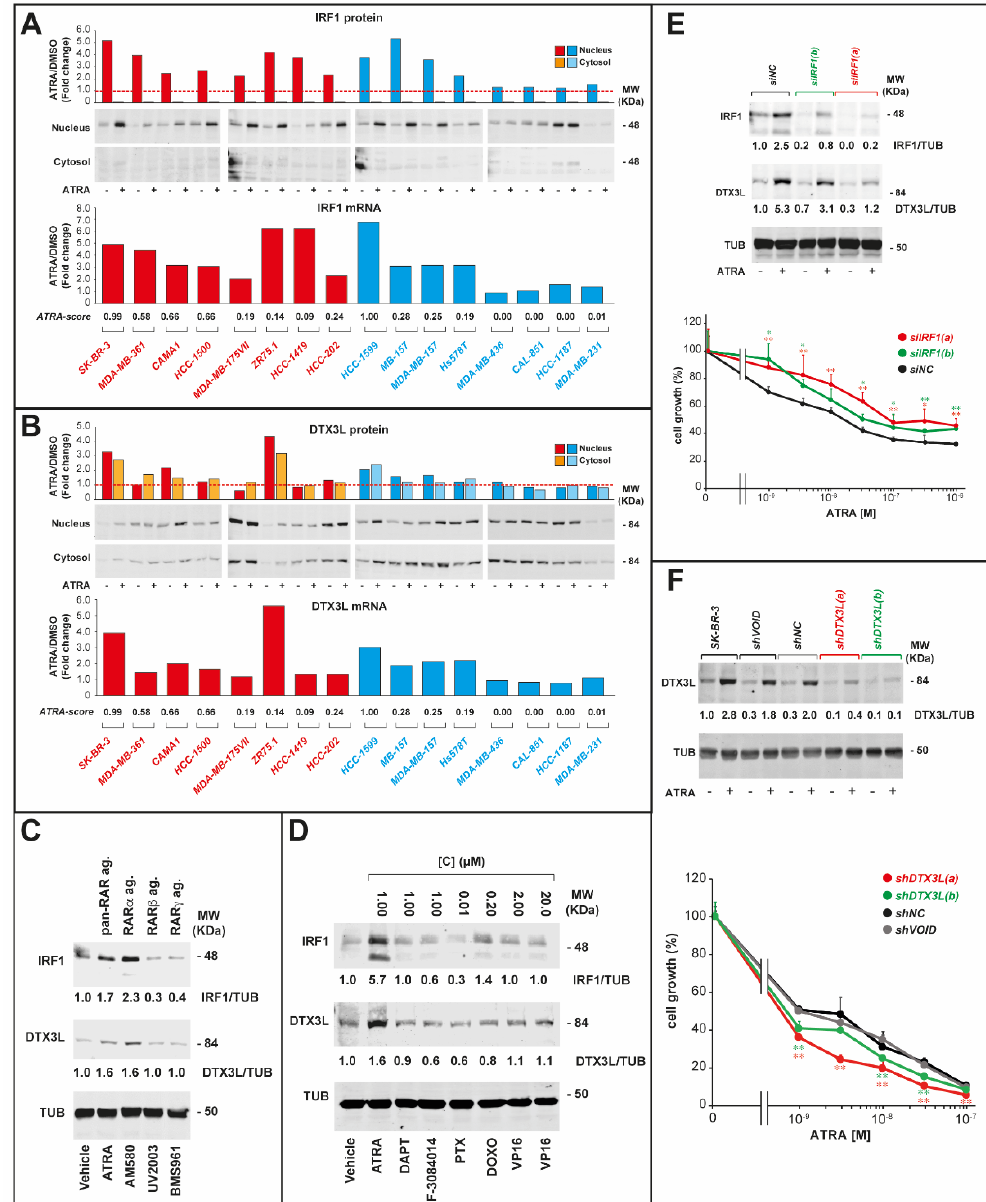
Figure 7. Effects of ATRA and derived retinoids on IRF1 and DTX3L in breast cancer cell-lines and functional significance of the two proteins in ATRA-dependent growth inhibition. ( A ) IRF1 and ( B ) DTX3L protein and mRNA levels were determined in vehicle (DMSO)- or ATRA (1 µ M)-treated cell-lines (24 h). IRF1 and DTX3L proteins were determined in the nuclear and cytosolic fraction by Western blot analysis. The column graphs above the Western blots show the densitometric results obtained. The column graphs underneath the Western blots show the effect exerted by ATRA on the expression levels of the IRF1 and DTX3L mRNAs (Taqman assays). ( C ) SK-BR-3 and ( D ) HCC-1599 cells were treated with vehicle and the indicated RAR agonist (1 µ M), the γ -secretase inhibitors, DAPT [(2S)-N-[(3,5-Difluorophenyl)acetyl]-L-alanyl-2-phenyl]glycine-1,1-dimethylethyl-ester] (1 µ M) and PF-3084014 [(2S)-2-[[(2S)-6,8-Difluoro-1,2,3,4-tetrahydro-2-naphthalenyl]amino]-N-[1-[2-[(2,2-dimethylpropyl)amino]-1,1-dimethylethyl]-1H-imidazol-4-yl]-pentanamide-dihydrobromide] (1 µ M), PTX (paclitaxel, 0.01 µ M), DOXO (doxorubicin, 0.2 µ M) and VP16 (etoposide, 2.0 and 20 µ M) for 24 h. Cellular extracts were subjected to Western blot analysis for IRF1, DTX3L and tubulin (TUB, loading control). IRF1/TUB = ratio of the densitometric results obtained for the IRF1 and Tubulin bands, DTX3L/TUB = ratio of the densitometric results obtained for the DTX3L and Tubulin bands. ( E ) SK-BR-3 cells were transfected with the small interfering RNAs, siIRF1(a),